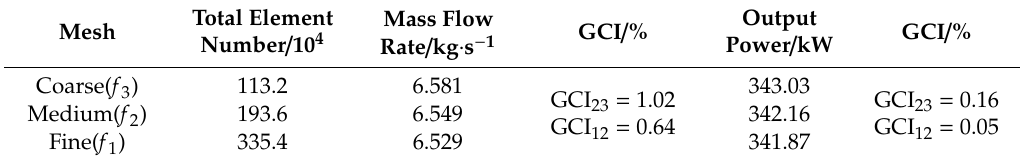
Table 3. Result of grid convergence index.